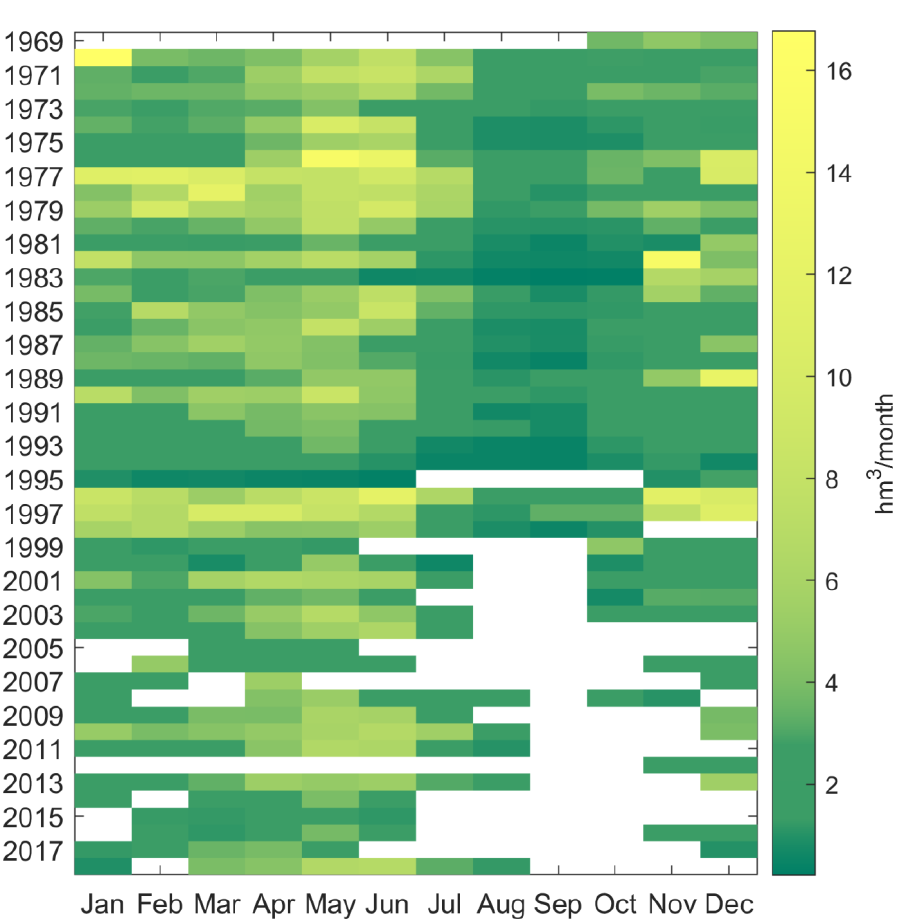
Figure 4. Observed monthly inflow data (hm 3 /month) for the hydrological period 1969–2018. White spaces represent no-data due to sensor failure.